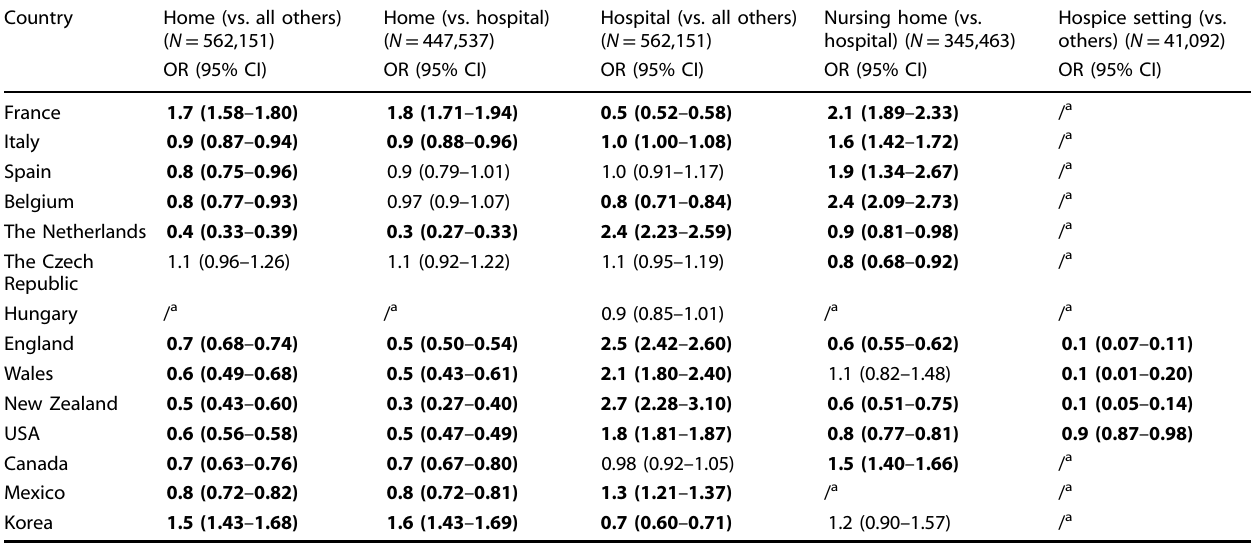
Table 4. Odds ratios of COPD vs. lung cancer patients (reference) strati fi ed by place of death: binary multivariable logistic regression models of death certi fi cates data from 14 countries during 2008 ( N = 562,151) Country Home (vs. all others) Home (vs. hospital) Hospital (vs. all others) Nursing home (vs. ( N = 562,151) ( N = 447,537) ( N = 562,151) hospital) ( N = 345,463)